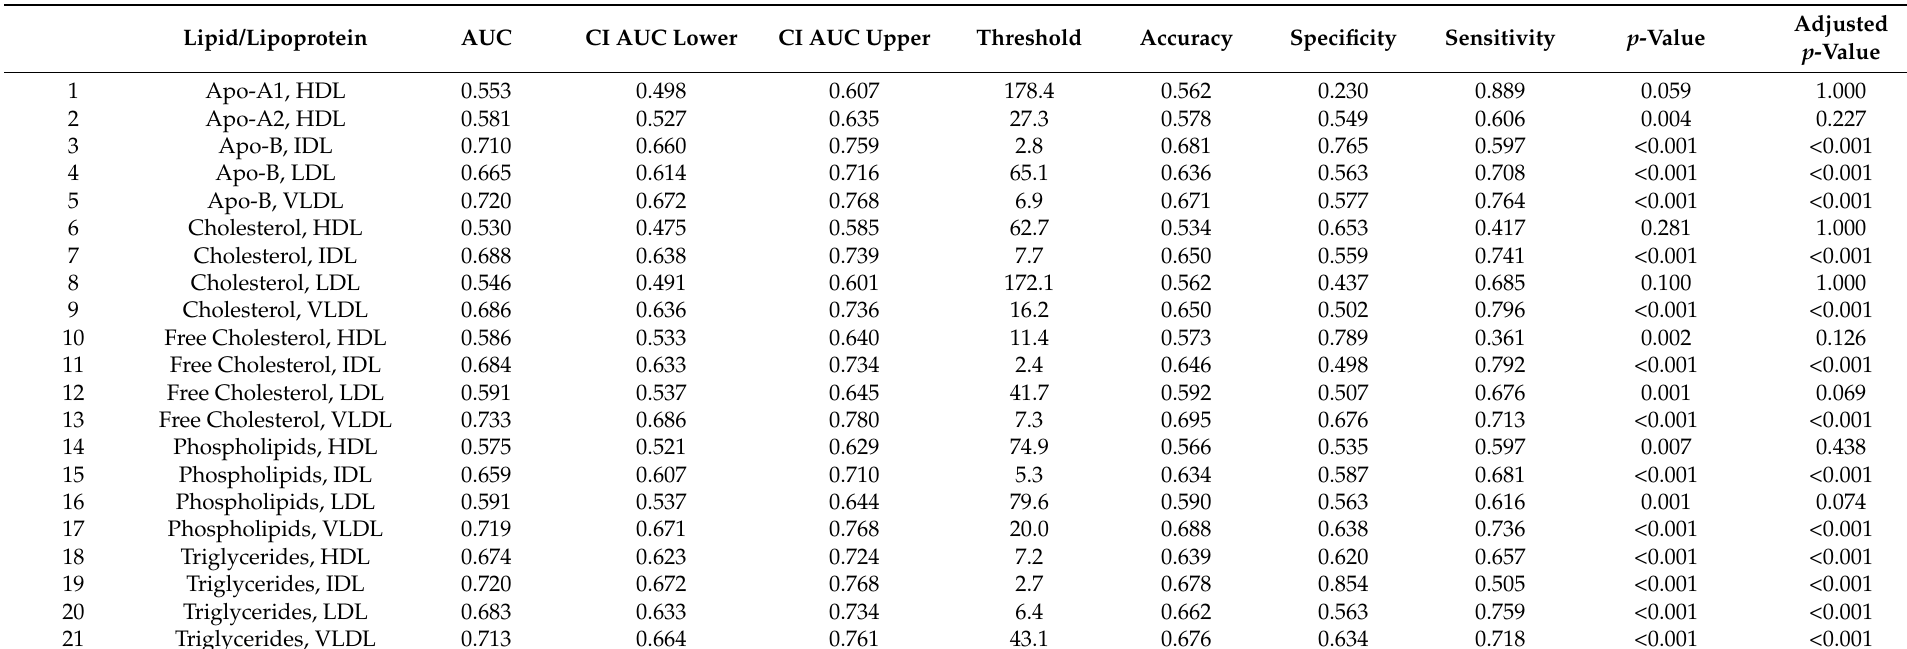
Table 4. ROC analysis of the concentrations of lipoproteins and lipid main fractions in young and old men. Age groups are defined in Table 1. Concentrations are in mg/dL. Adj stands for adjusted. CI indicates the 95% Confidence